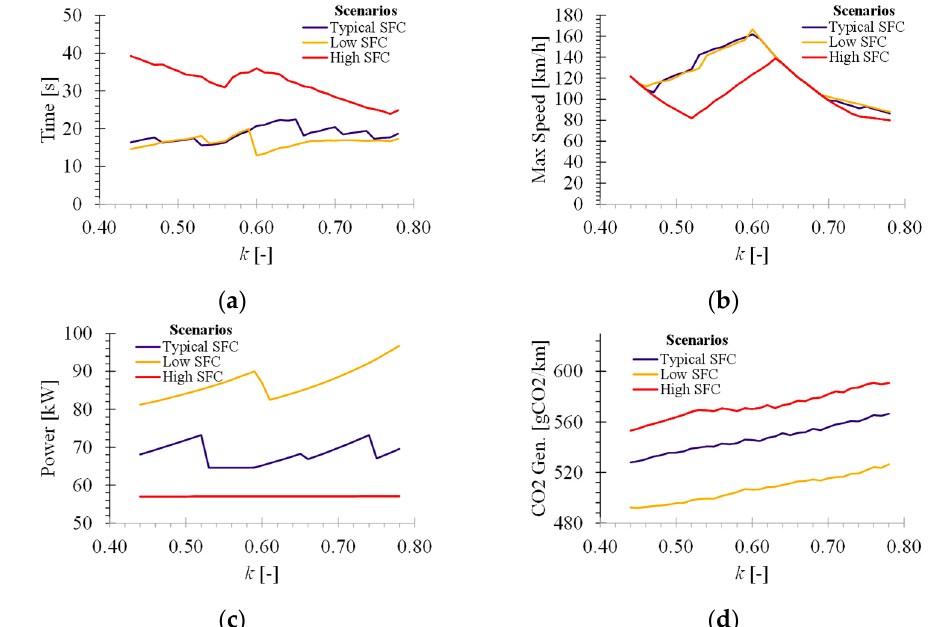
Figure A1. Effect of varying the ratio between gears ( 𝑘) in the different SFC scenarios for ( a ) accel- eration capacity, ( b ) maximum speed, ( c ) maximum power required for the motor, and ( d ) CO 2 emissions.